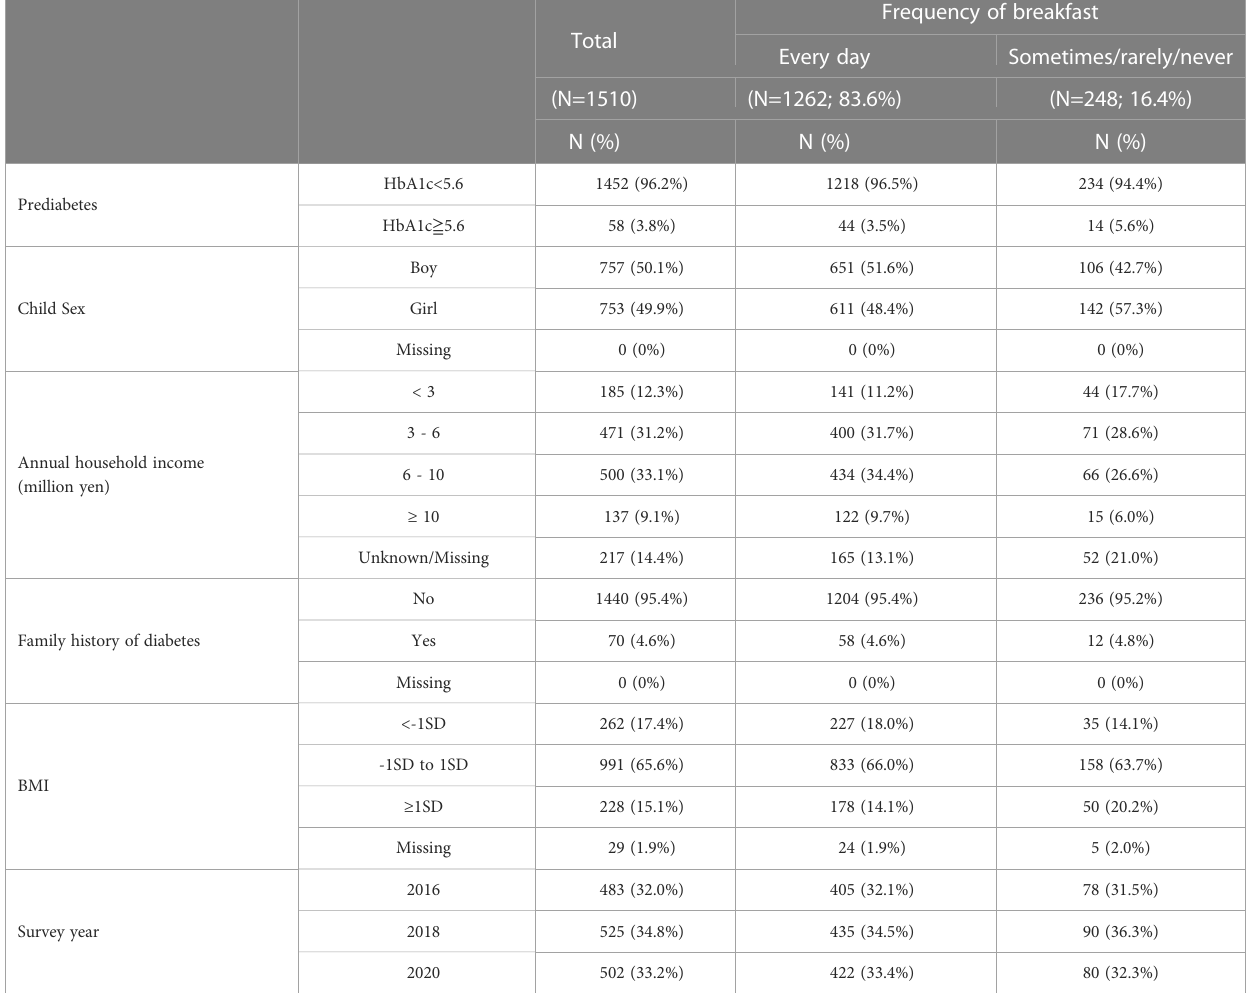
TABLE 1 Characteristics of participants